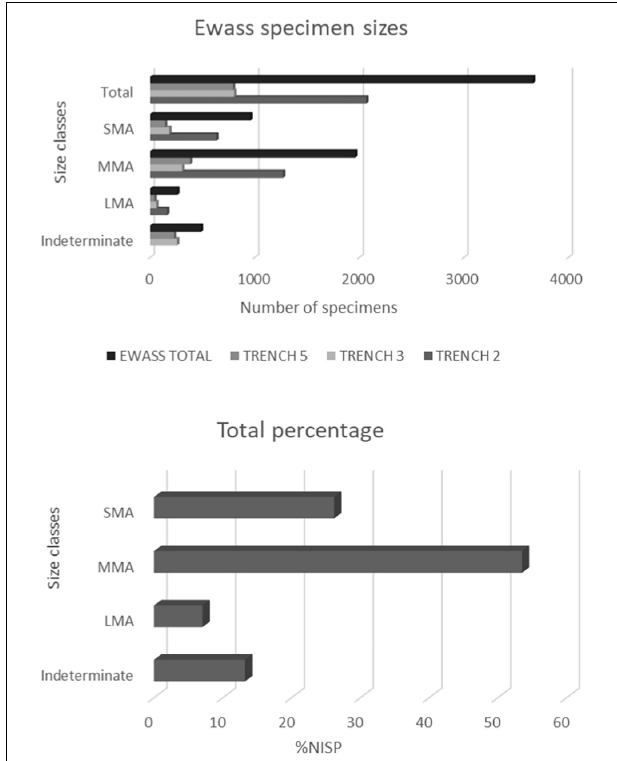
FIGURE 2 | Frequency bar chart representation of Ewass size classes across the trenches, %NISP of size classes across the